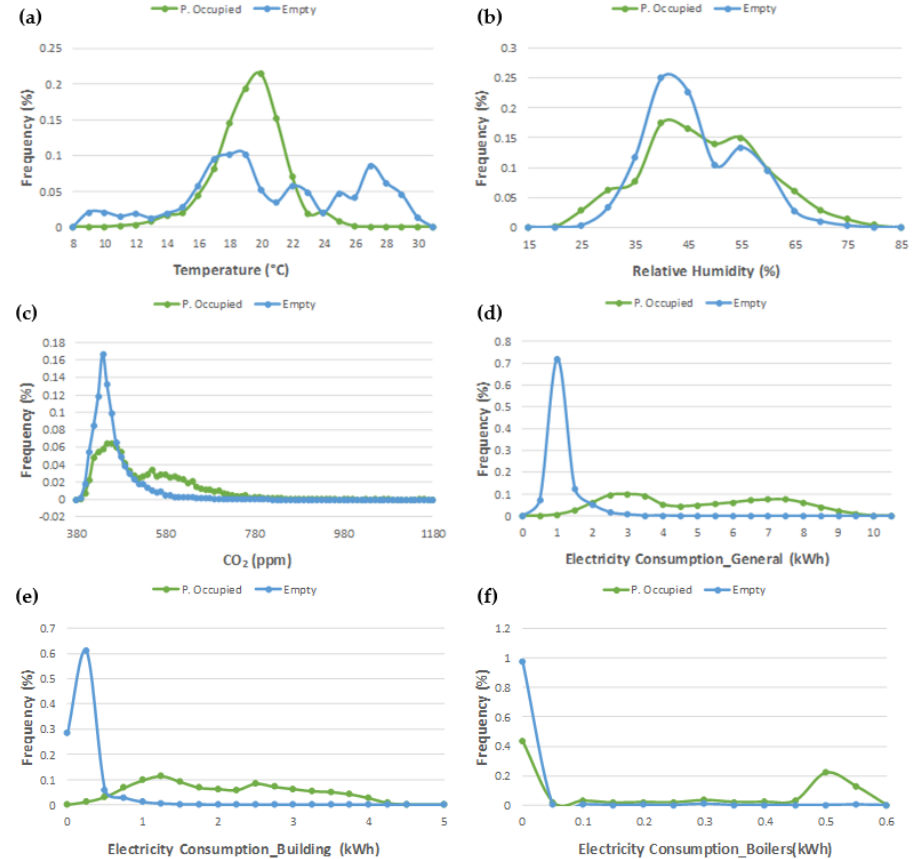
Figure 5. Annual histograms of different variables assessed as possible indicators of occupancy status in schools: ( a ) temperature, ( b ) relative humidity, ( c ) CO 2 concentration, ( d ) general electricity consumption, ( e ) building electricity consumption and ( f ) boilers electricity consumption. Blue line represents when the classroom was empty vs. green line when the room might be